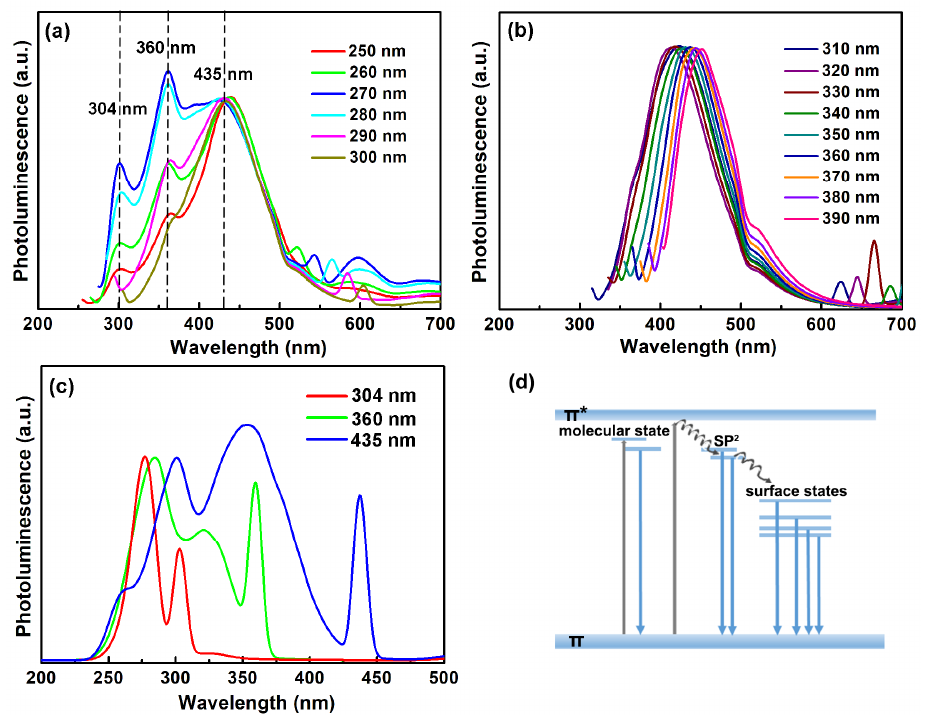
Figure 5. Normalized PL spectra of the CNDs excited in the wavelength range of ( a ) 250–300 nm and ( b ) 310–390 nm. ( c ) Photoluminescence excitation (PLE) spectra of the CNDs recorded at 304, 360 and 435 nm. ( d ) Scheme of the energy structure of the CNDs.